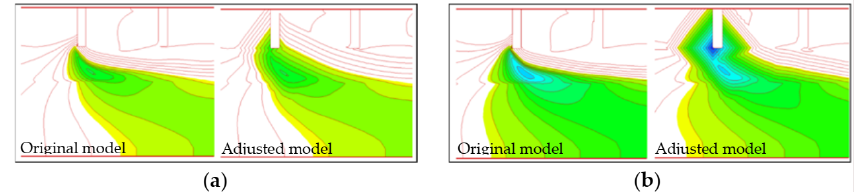
Figure 15. Local view of the simulated non-dimensional bed changes around the spur dike: original and adjusted model in ( a ) case G4a and ( b ) case